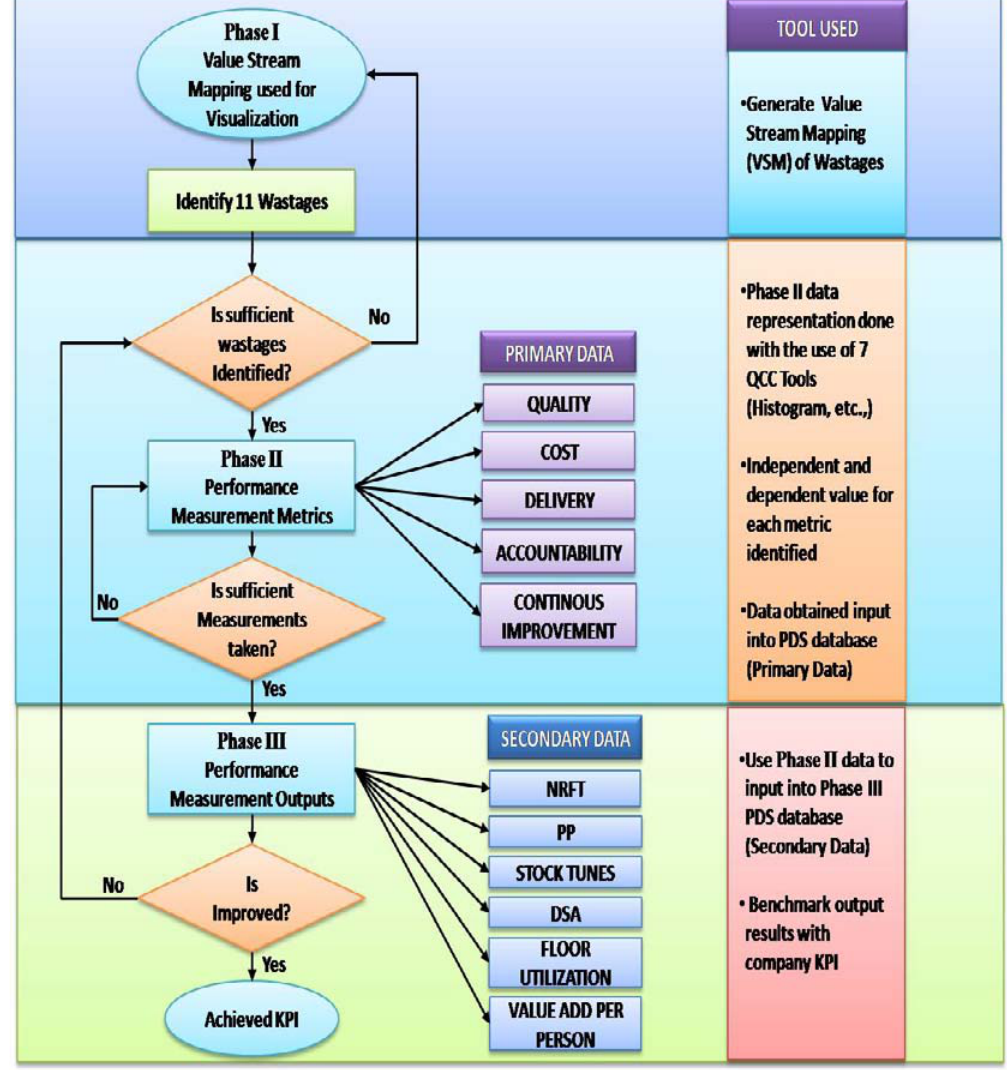
Figure 2. “Flow chart on methodology execution for PDS implementation”. Source: Puvanasvaran et al.